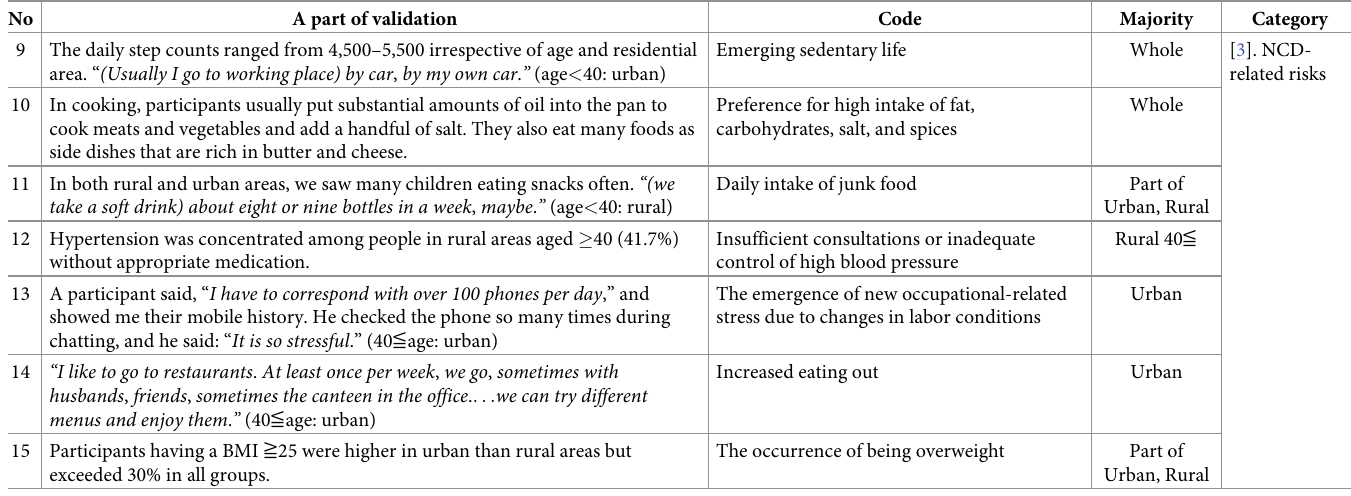
Table 5. Theme II: Situation of NCD-related risks: Variation, code, categories and themes.